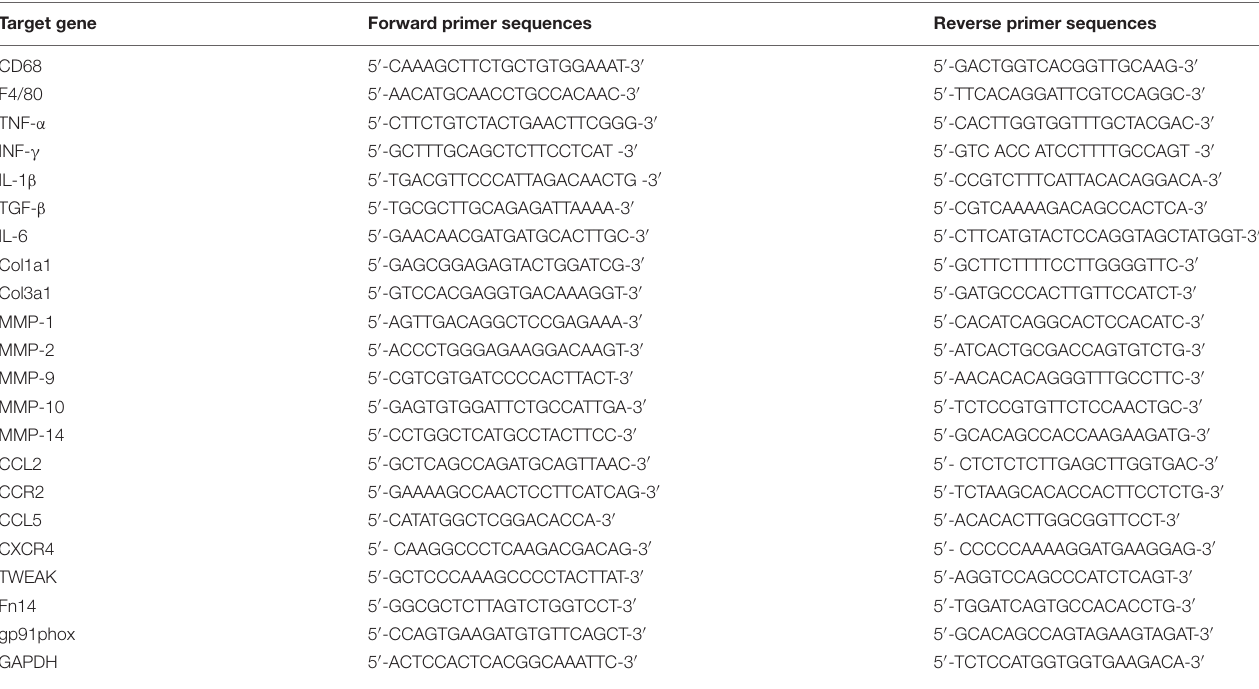
TABLE 1 | Primers used for